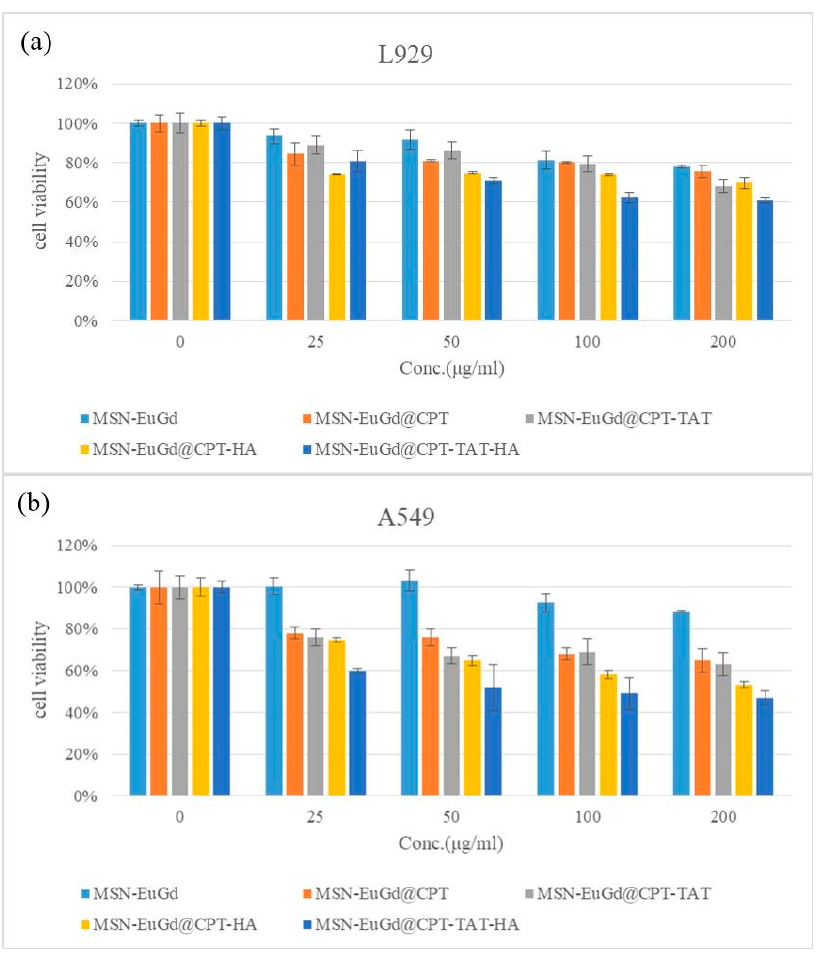
Figure 5. MTT assays for MSN-EuGd, MSN-EuGd@CPT, MSN-EuGd@CPT-TAT, MSN-EuGd@CPT-HA, and MSN-EuGd-TAT-HA using L929 and A549 cells.